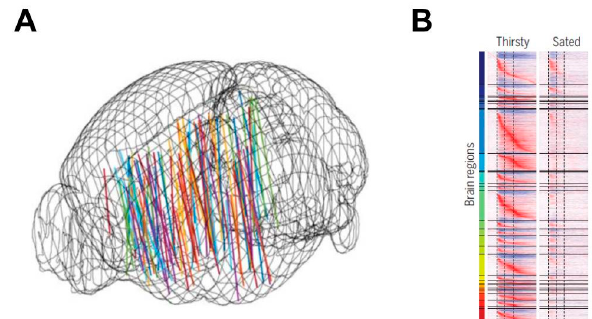
Figure 6. ( A ) Tracks of neuropixel electrode activations, recorded in mouse forebrain and midbrain regions during head-fixed, thirst-motivated choice behavior. ( B ) Brainwide activity dynamics of individual neurons from 31 brain loci, in response to an olfactory cue, while a mouse was both thirsty and sated. Reproduced with the permission of the publisher [94].